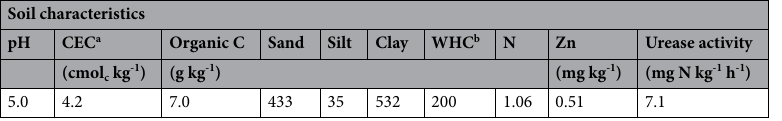
Table 3. Chemical and physical properties of the studied soils. a CEC, cation exchange capacity. b WHC, water- holding